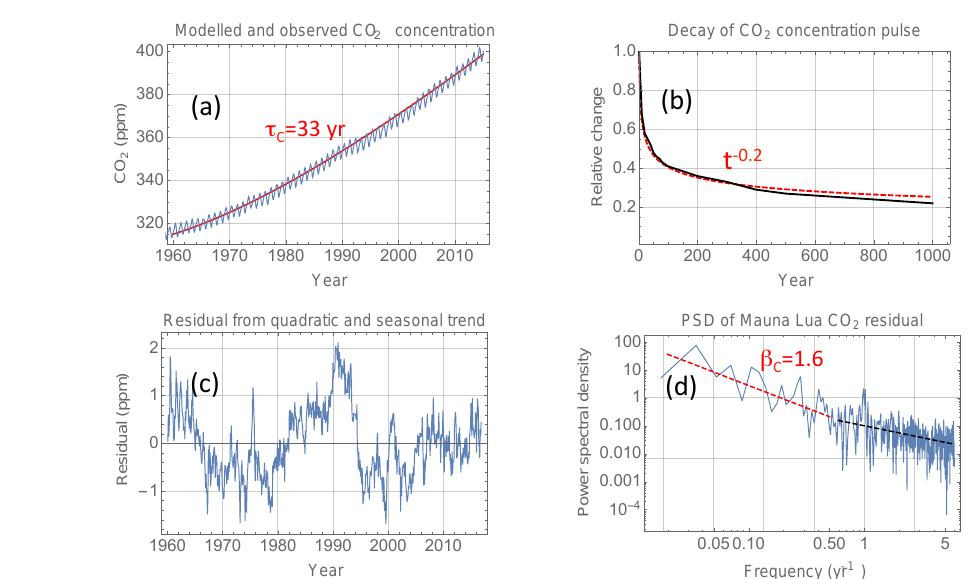
Figure 2. Panel (a) : blue curve shows the atmospheric CO 2 concentration as measured by the Mauna Loa observatory. The red curve is the concentration computed from Eq. (5) with τ C 33 years, (cid:49)C 1960 74Gt C (corresponding to an anomaly of 315–280 = = C 0 594Gt C (corresponding to 280ppm). Panel (b) : black curve is the multimodel mean CO 2 response to a pulse of emitted CO 2 as given = in Joos et al. (2011). The red, dashed curve is a least-square fit of a function of the form α C t β C / 2 − 1 with the estimated β C the residual Mauna Loa signal after subtracting the quadratic polynomial and seasonal trends. Panel (d) : the power spectral density of the residual in (c) estimated by the periodogram presented in a log–log plot. The black, dashed line has negative slope β C dashed line has β C 1 . =